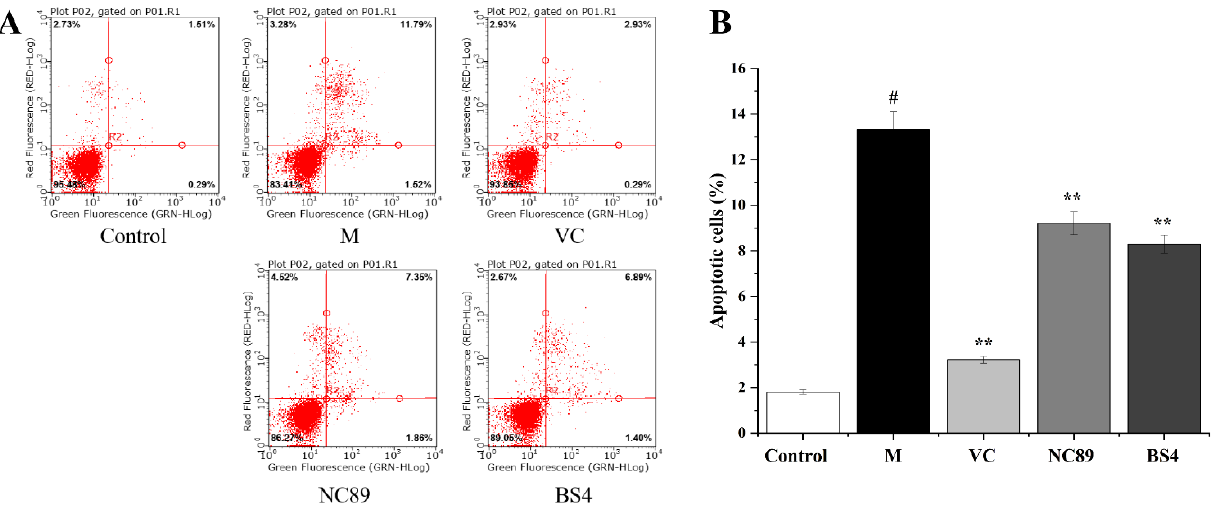
Figure 4. Cytoprotective effects of NC89 and BS4 tobacco seed oils in H 2 O 2 -induced HepG2 cells. ( A ): Flow cytometry analysis; ( B ): the cell apoptosis percentage. Values are presented as the mean ± SD ( n = 3). # p < 0.05 vs. Control group; ** p < 0.01 vs. M group.